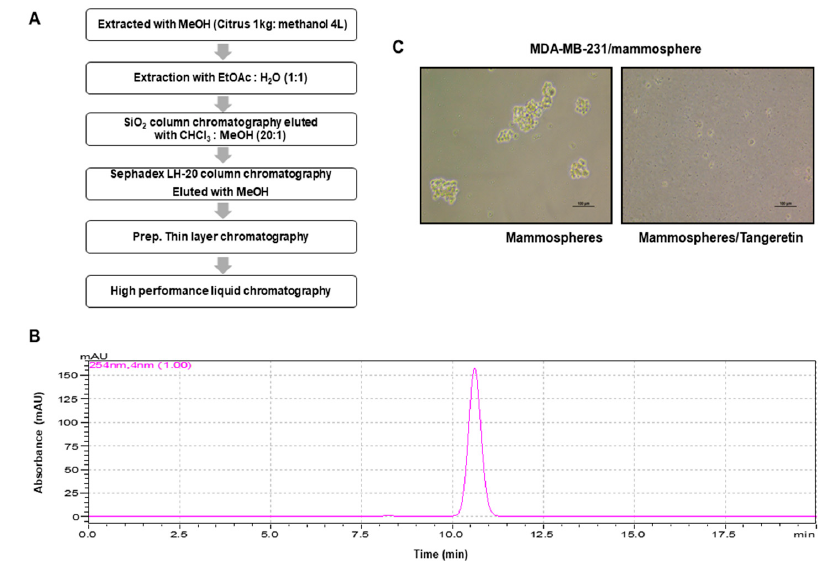
Figure 1. Purification protocol for a CSC inhibitor derived from citrus peels and a mammosphere